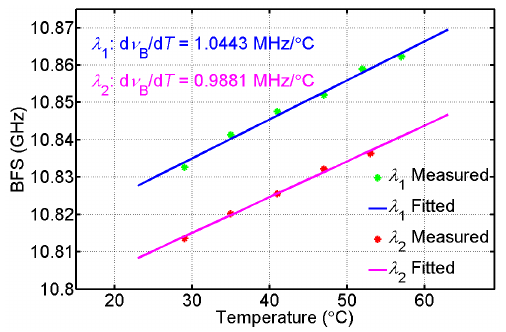
Figure 3. Brillouin frequency shift versus temperature at two wavelengths: λ 1 and λ 2 .